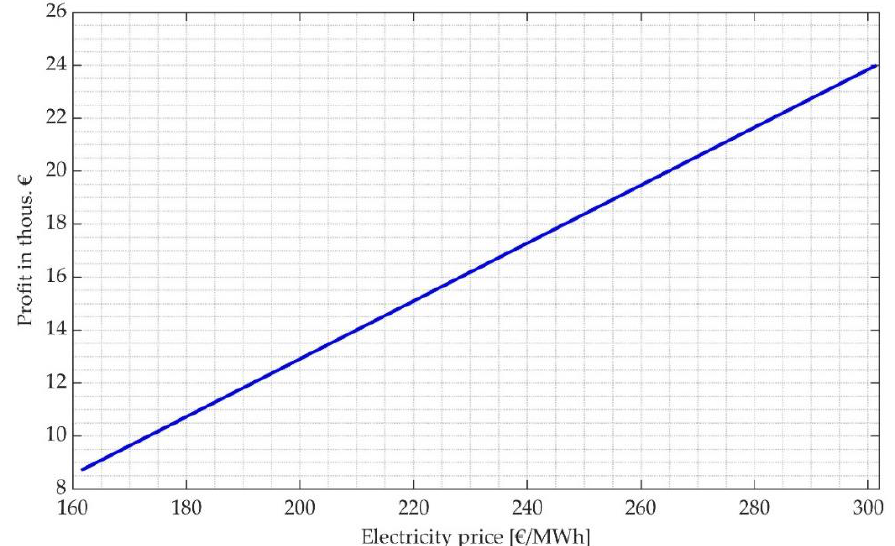
Figure 11. A graph representing potential profits from the sale of energy depending on electricity prices. Table 6. Results for the adopted